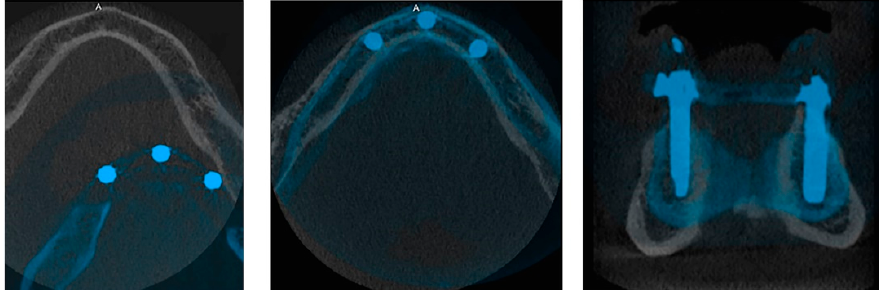
Figure 1. Registration of the master model (MM) and a test mandible (A: anterior). Implants are oriented into the optimal position where they are surrounded by 1 mm of bone.